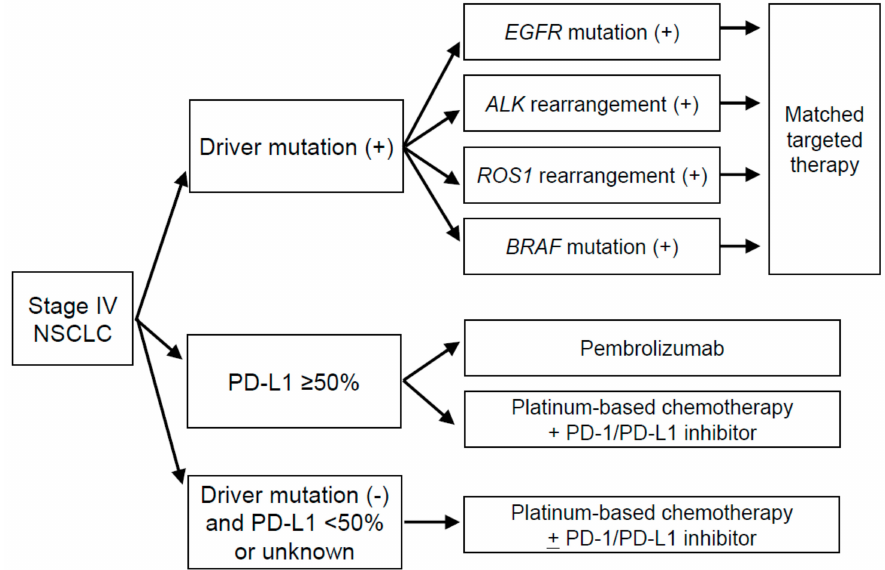
Figure 1. Treatment strategy for stage IV non-small cell lung cancer